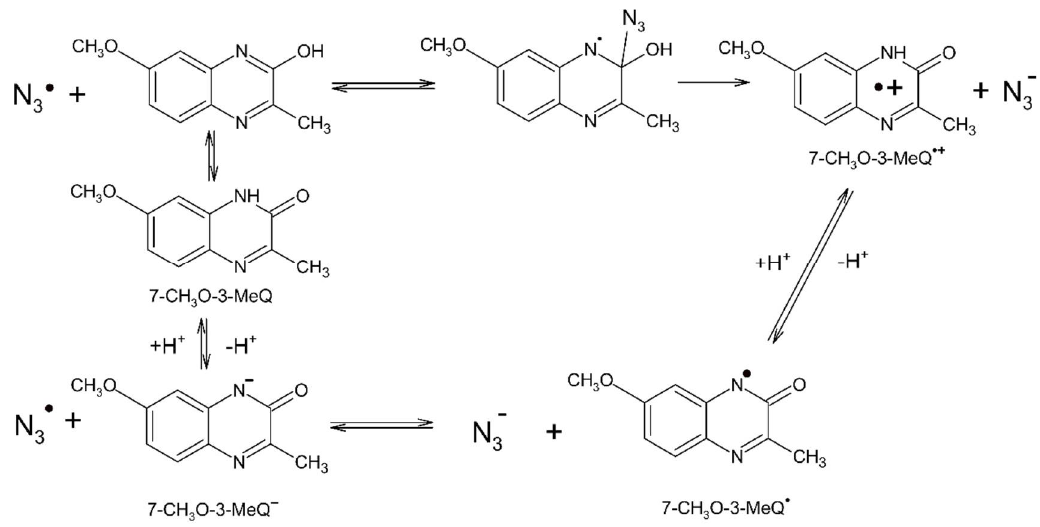
Scheme 3. Reaction pathways involving N 3● and 7-OCH 3